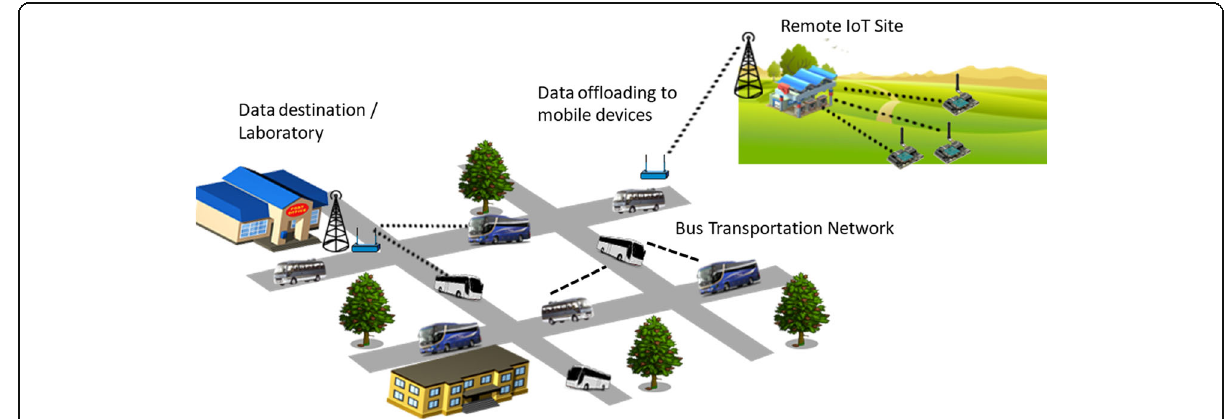
Fig. 1 Data offloading and opportunistic peer to peer data transfer toward